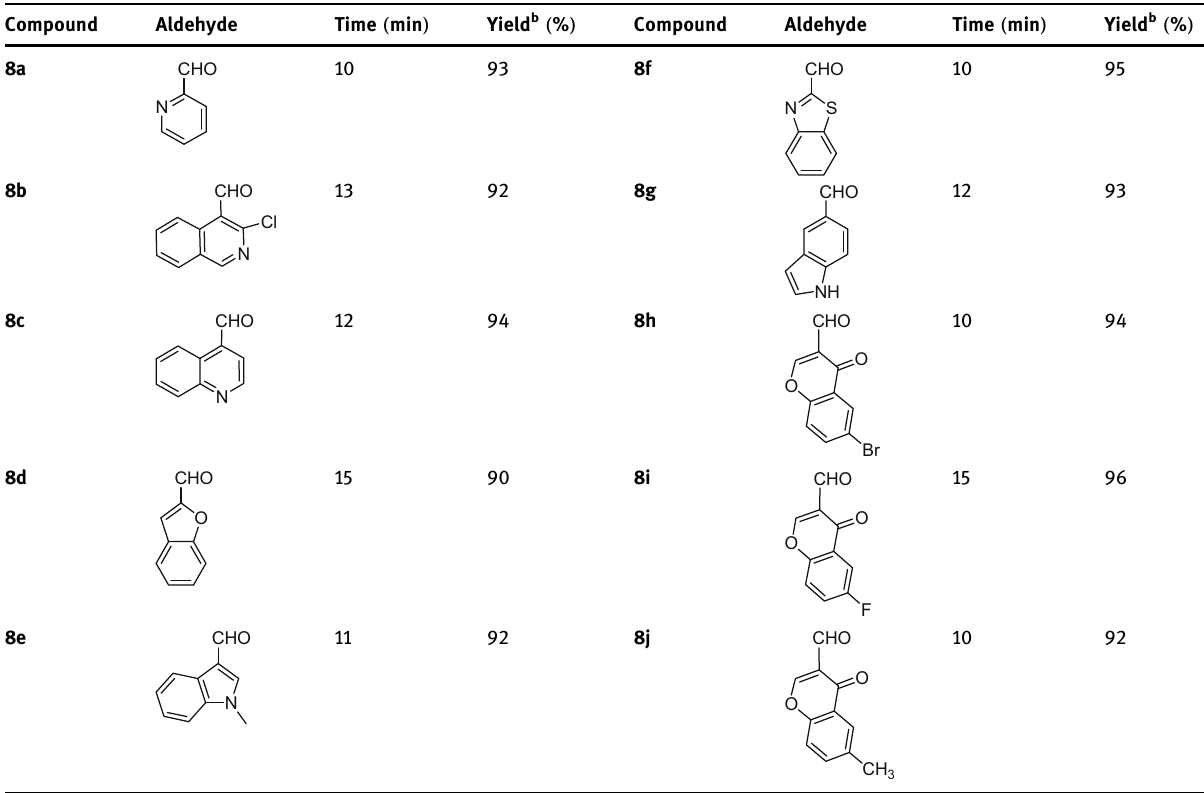
Table 4: MW - mediated synthesis of α - aminophosphonates ( 8a – j ) a